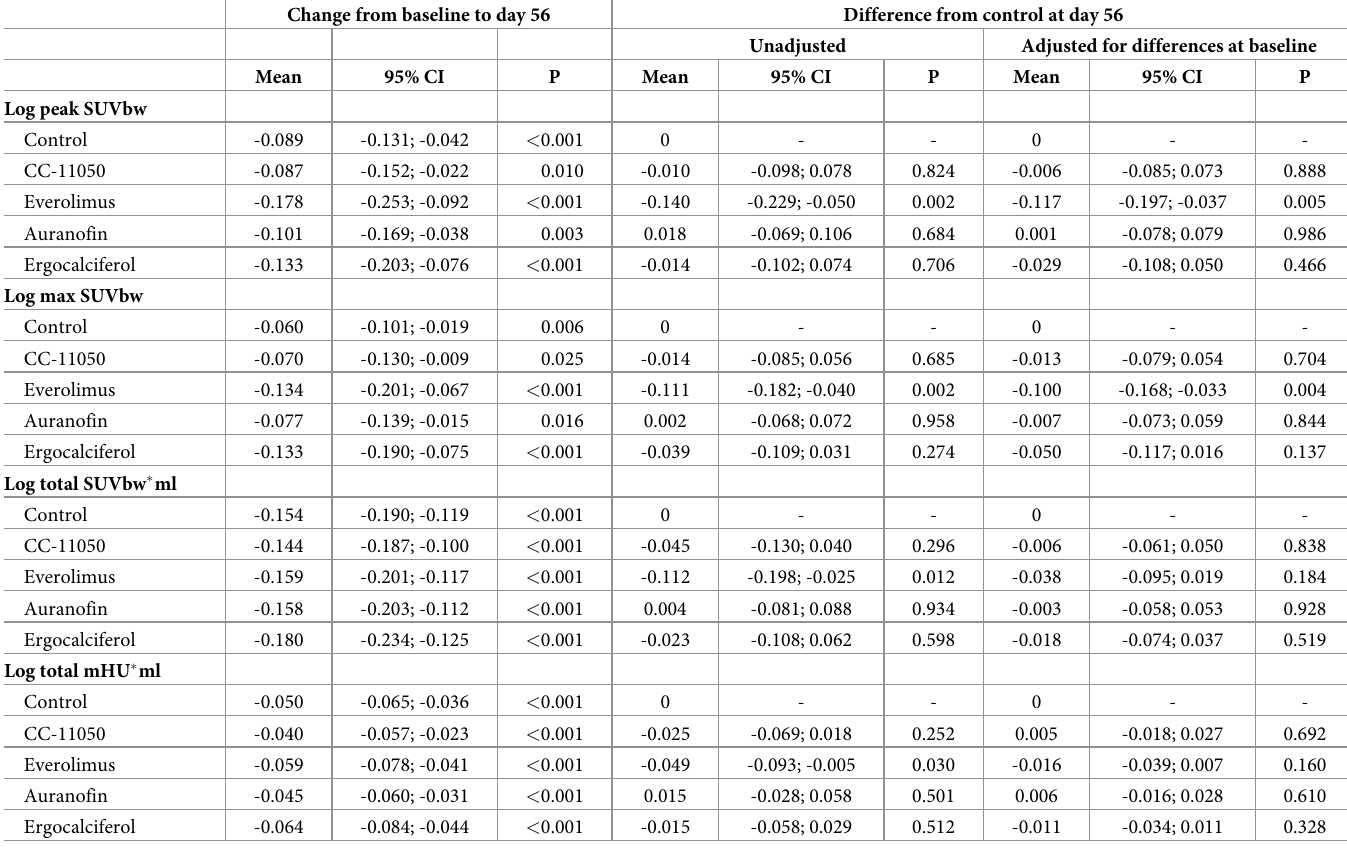
Table 2. Effect of treatment on PET/CT parameters. Change from baseline to day 56